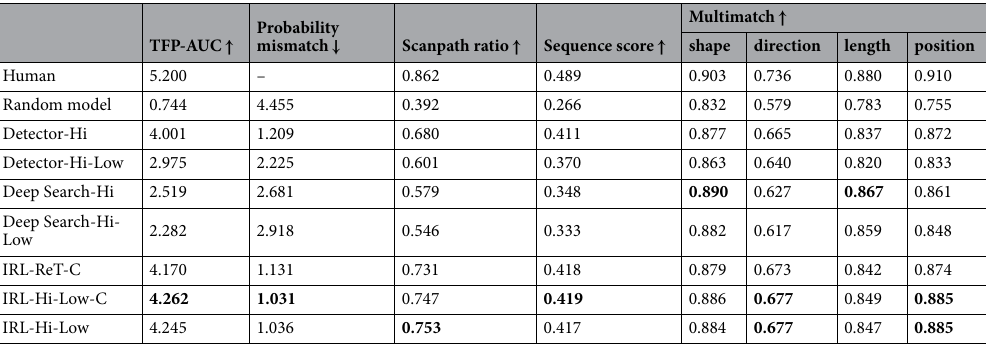
Table 1. Results from fixation-prediction models (rows) using multiple scanpath metrics (columns) applied to the COCO-Search18 test images. Arrows indicate the direction of better prediction success, and values in bold indicate best predictions across the model comparison. In the case of Sequence Score and MultiMatch, “Human” refers to an oracle method whereby one searcher’s scanpath is used to predict another searcher’s scanpath; “Human” for all other metrics refers to observed behavior. See the main text for additional details about the scanpath-comparison metrics, and SM3 for purely spatial comparisons using the AUC, NSS, and CC